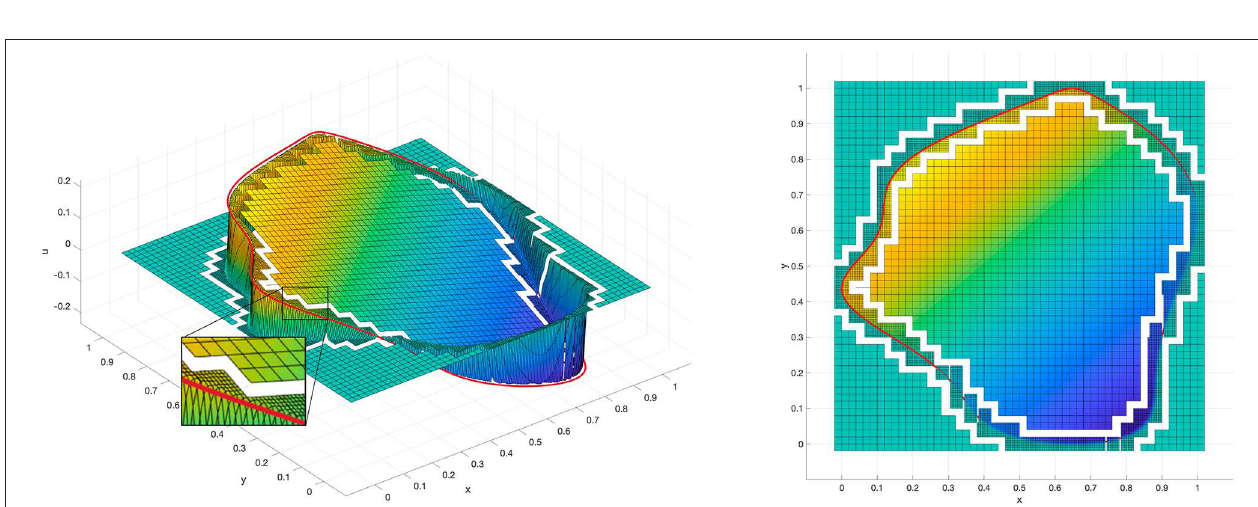
FIGURE 7 | Exemplary raw results for the displacement component u obtained on a grid with two discretization levels for the same problem as it is displayed in Figure 2 with a single regular grid. The results on the fine grid level close to the boundary (the analytical solution is displayed with the red line) appear similar to the results which were obtained with the significantly more expensive technique used in Figure 2 . The white borders between the two discretization levels are displayed for the purpose of a better visualization of the two discretization levels.